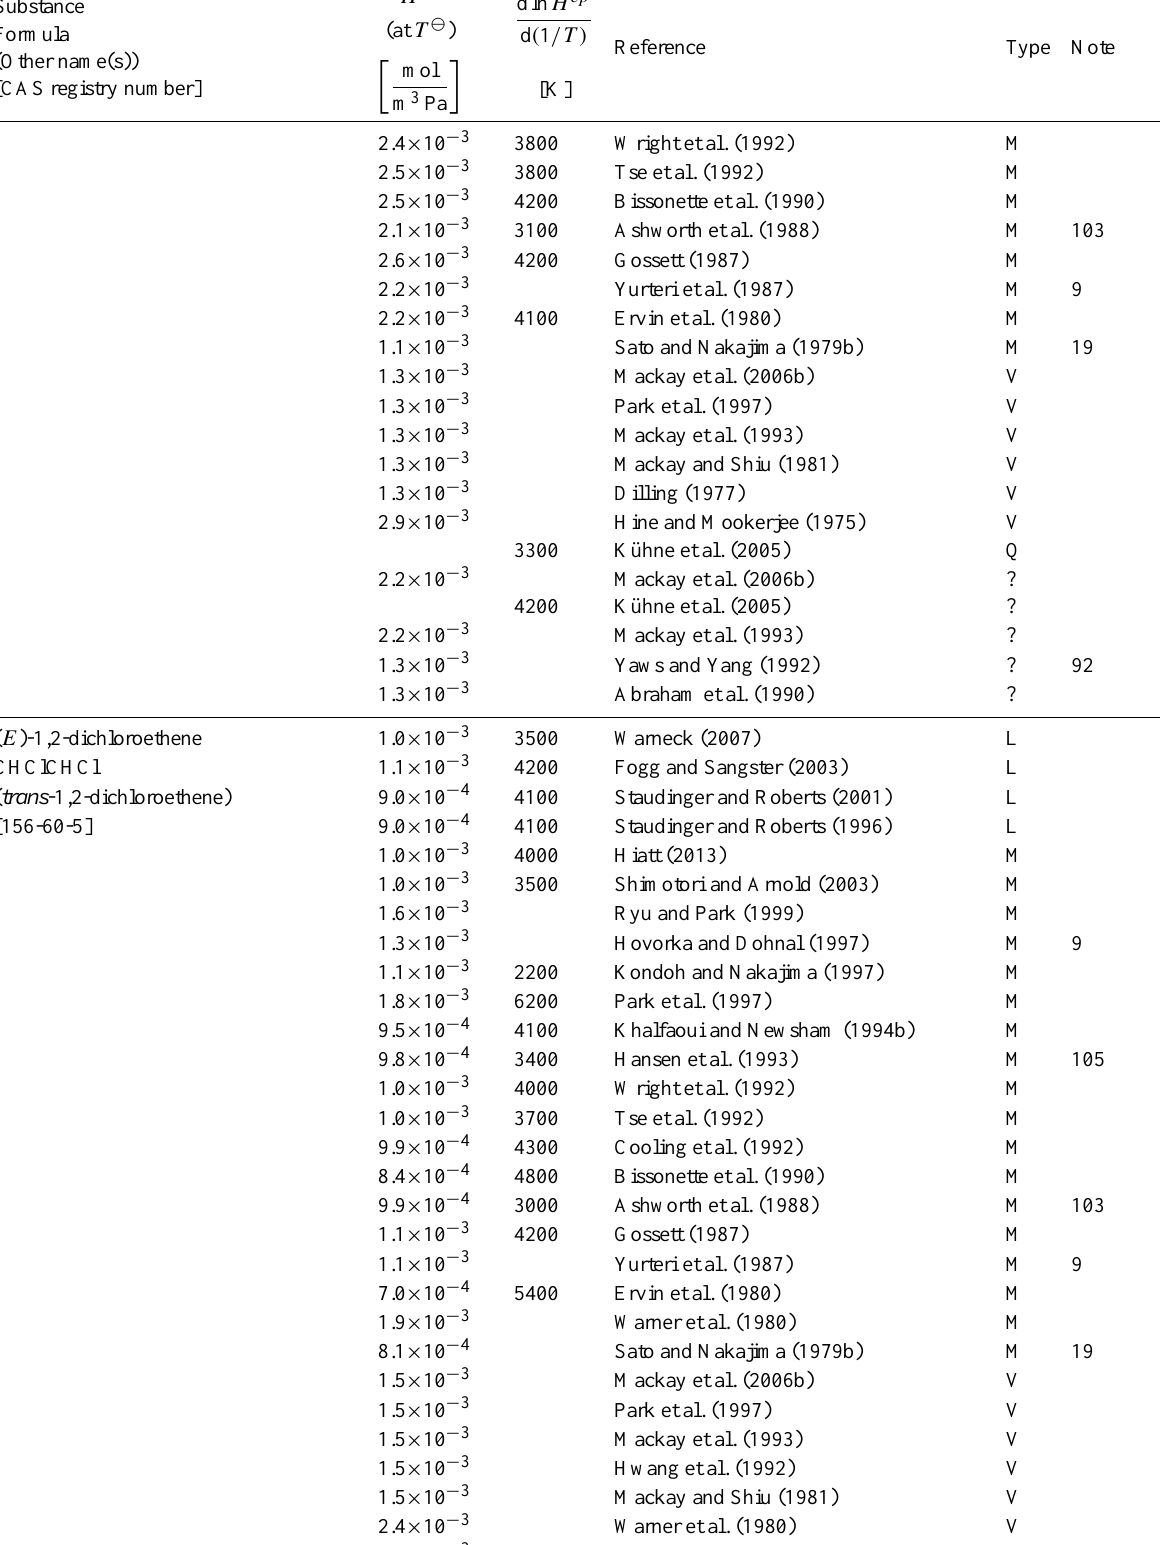
Table 6: Henry’s law constants for water as solvent